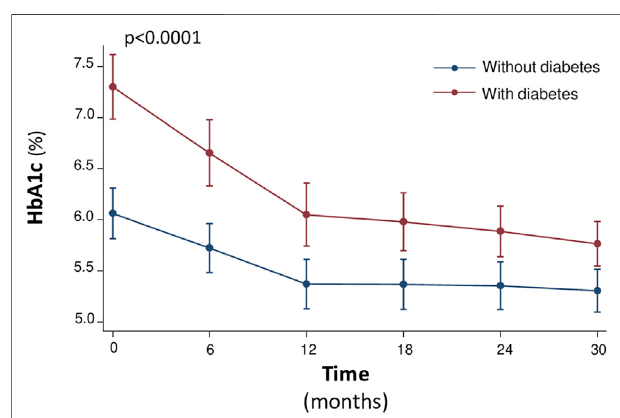
FIGURE 2 | Median values of the HbA1c (%) at baseline and every 6 months, during the 30-month